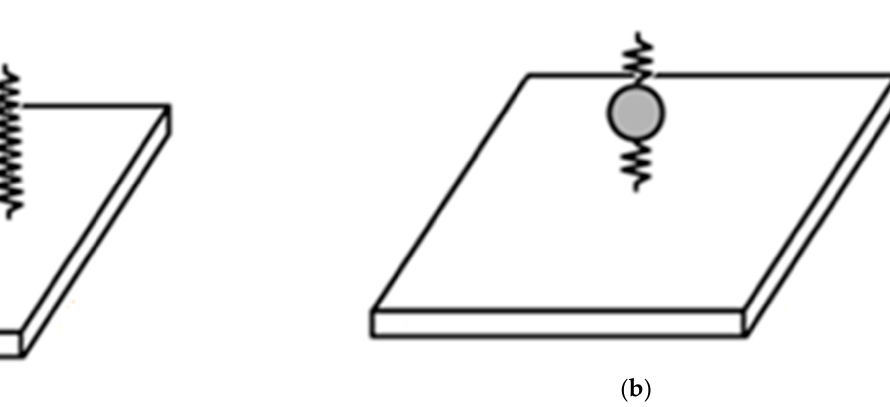
Figure 3. The unit cells of simplified models (the upper plate is ignored) with ( a ) four and ( b ) zero springs surrounded.